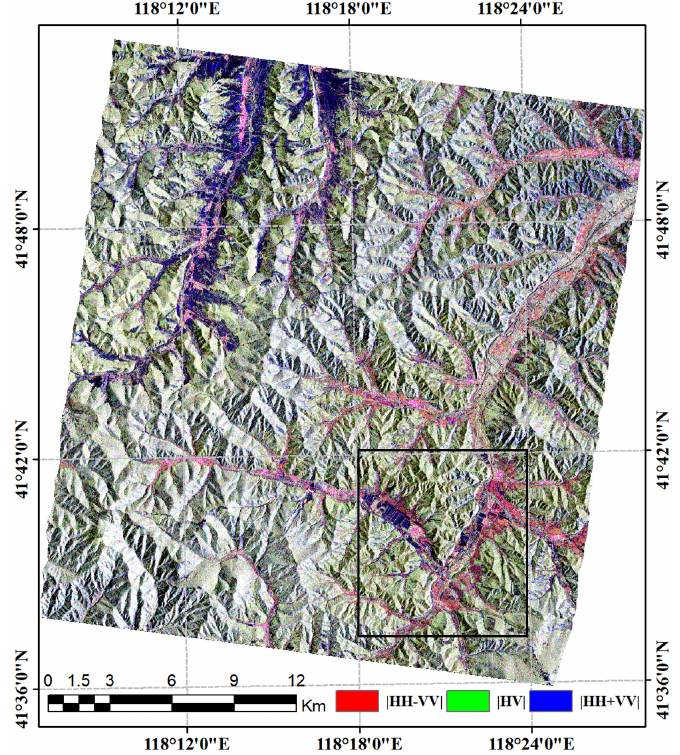
Figure 5. The Pauli RGB after GTC based on RPC model.